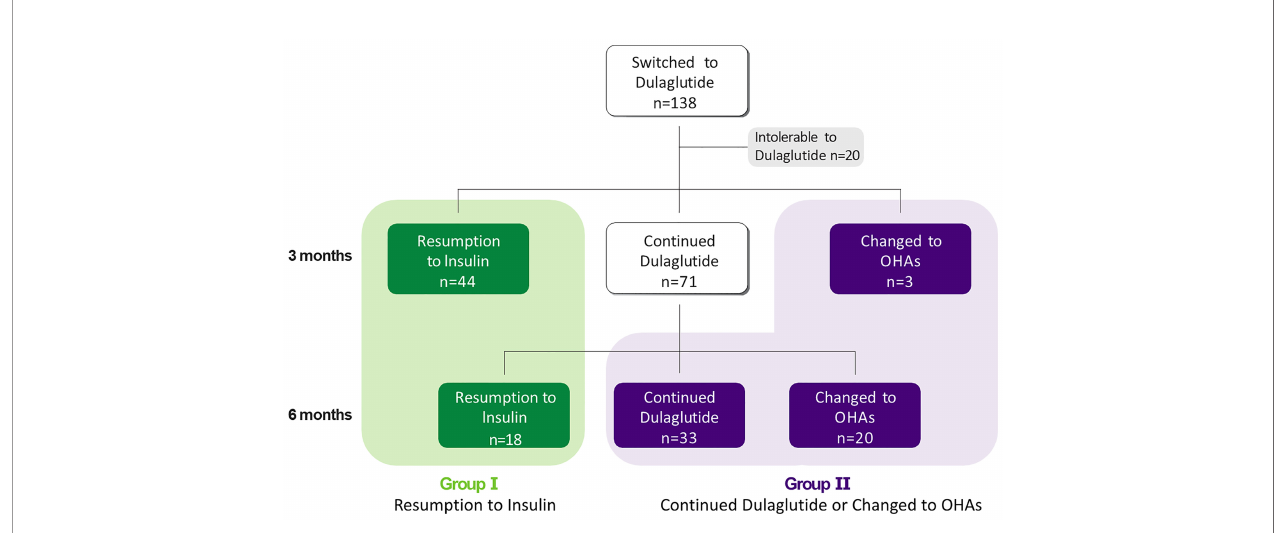
FIGURE 1 | A total of 138 patients switched from insulin to dulaglutide. 20 patients were not resistant to Dulaglutide and 118 patients were followed for six months after conversion. 44 patients resumed insulin, 71 patients continued to use dulaglutide. And three patients switched from dulaglutide to oral hypoglycemic agents after three months. Additional 18 patients resumed insulin, 33 patients continued using dulaglutide and 20 patients switched to OHA after six